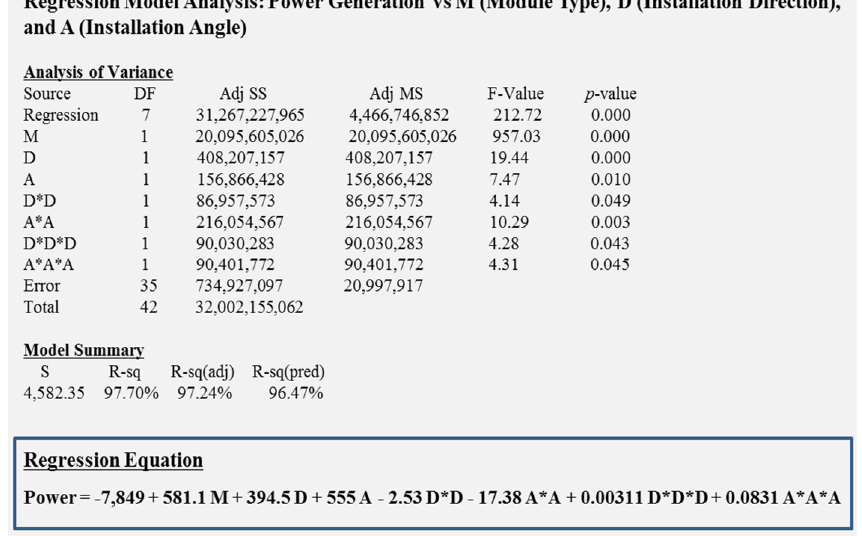
Figure 16. Regression analysis of the cumulative power generation over one year for different PV module types, installation directions, and angles.